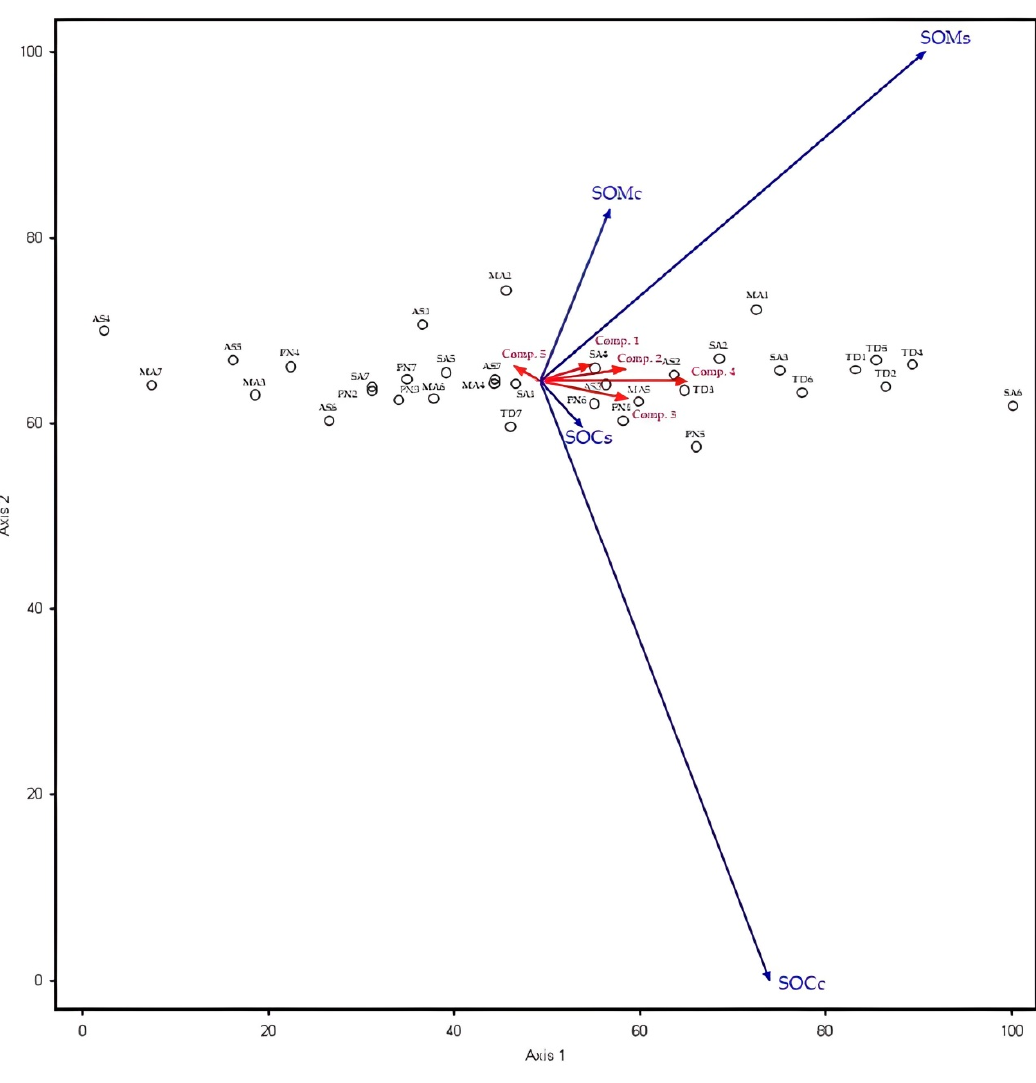
Figure 4. Effect of tree vegetation characteristics and environmental factors on the concentration and stock of SOC and SOM in the protected forest of Kulon Progo Community Forestry. SOCc is SOC concentration, SOMc is SOM concentration, SOCs is SOC stock and SOMs is SOM stock.